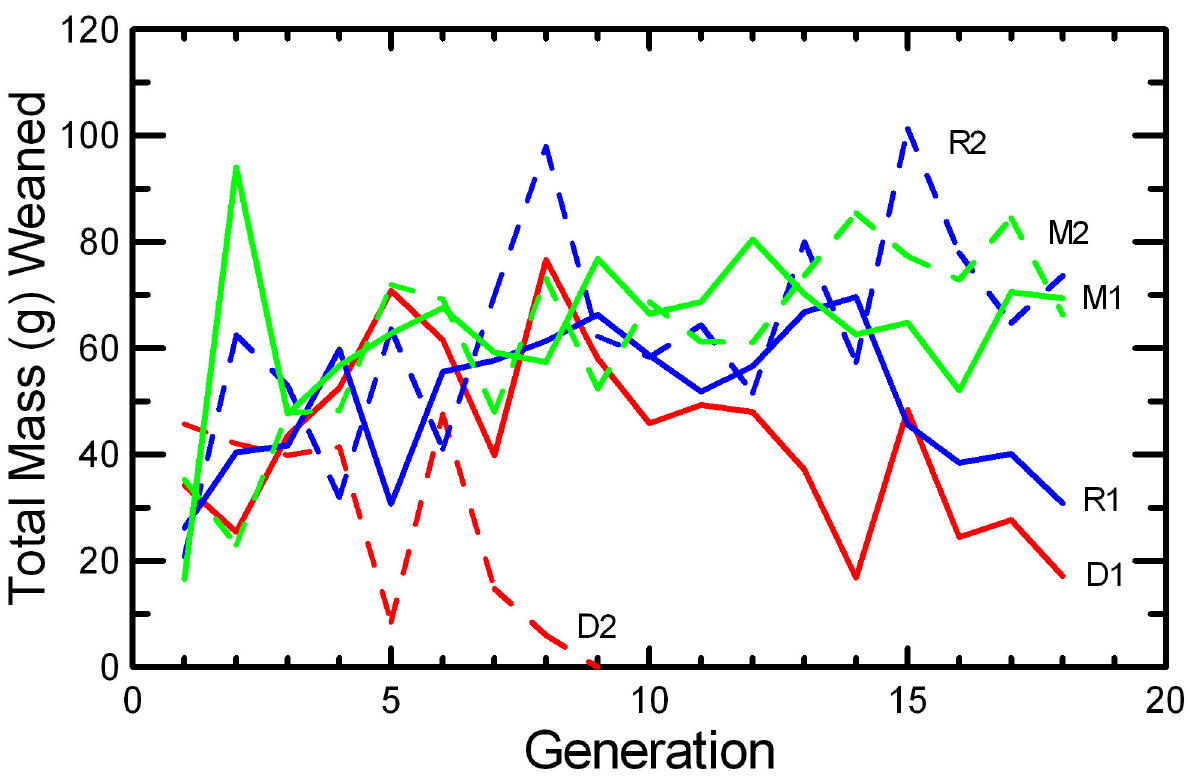
Figure 10. Overall reproductive success. The mean total mass (g) of progeny weaned per pair in the 0, 1, or 2 litters produced is given for the two replicates of RAN (blue), MK (green), and DOC (red) experimental populations.